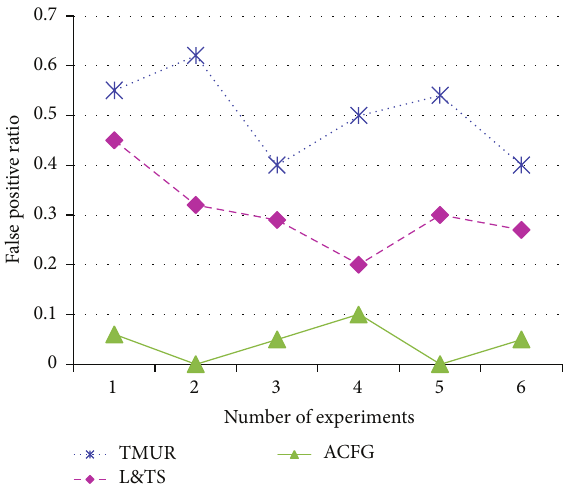
Figure 16: False positive ratio of TMUR, L&TS, and ACFG.